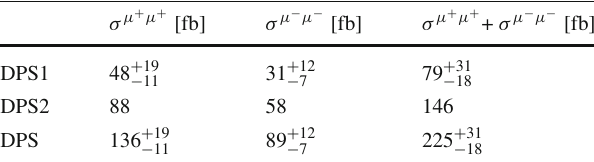
Table 3 Fiducial cross sections for ssWW DPS cross sections for the positive (left), negative (central) and charged summed (right) dimuon final state for all DPS contributions. The quoted errors follow from the propagation of σ ef f